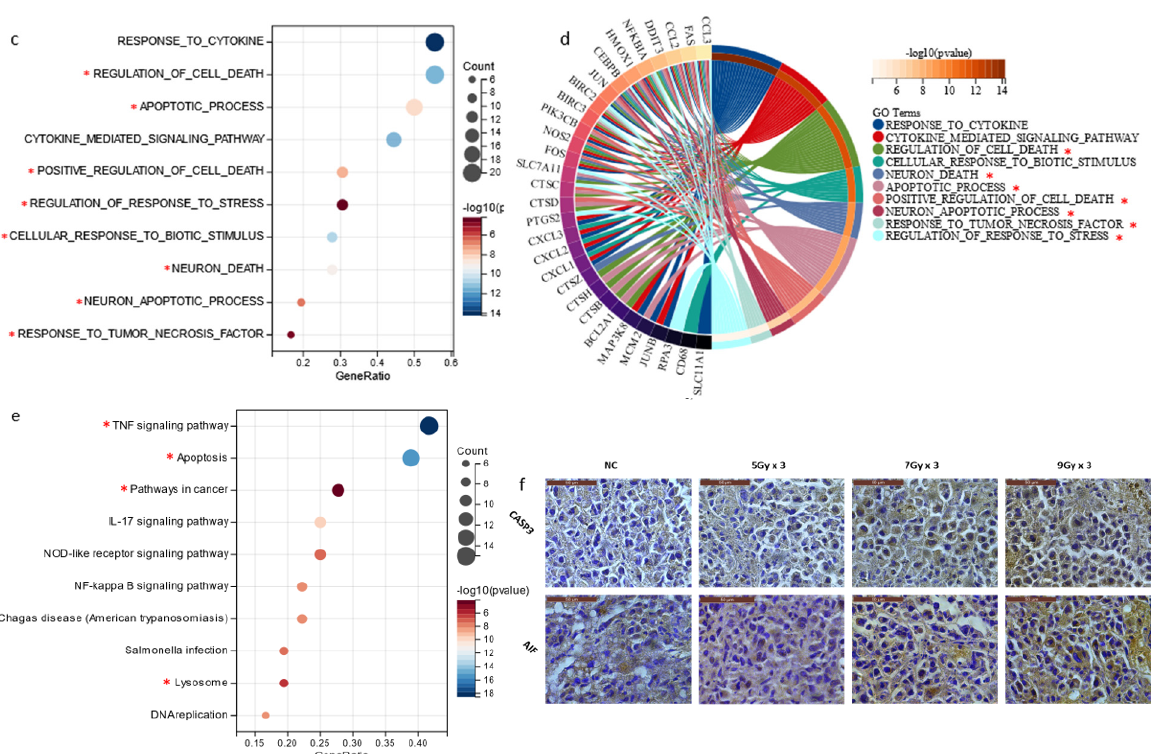
Figure 1. Radiation Inhibited Tumor Growth and Induced Apoptosis in vivo. ( a , b ) Tumor-bearing rat models were established. The IR group was given 7Gy × 3 and 9Gy × 3 fractions imitating SBRT using an X-ray accelerator ( a ) and gamma-knife ( b ), respectively, and the tumors were harvested and measured 7/14 days after IR treatment; ( c , d ) GO biological process (BP) enrichment analysis of the selected top up-regulated gene set—the terms we were interested in are marked with *; ( e ) KEGG enrichment analysis of the top up-regulated gene set—the terms we were interested in are marked with *; ( f ) Immunohistochemical staining of tumor tissues after different doses of IR, Caspase3, and AIF antibodies.